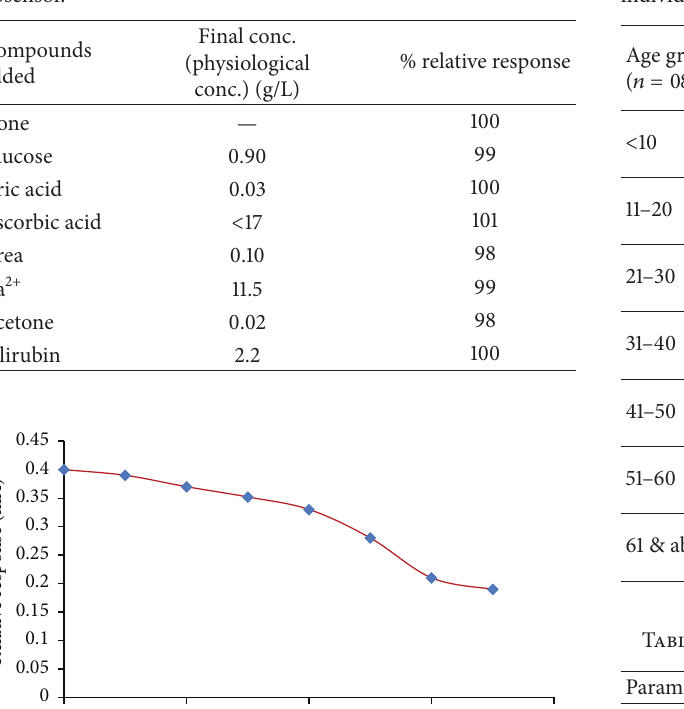
Table 3: Effect of different serum substances on the working of CH biosensor.